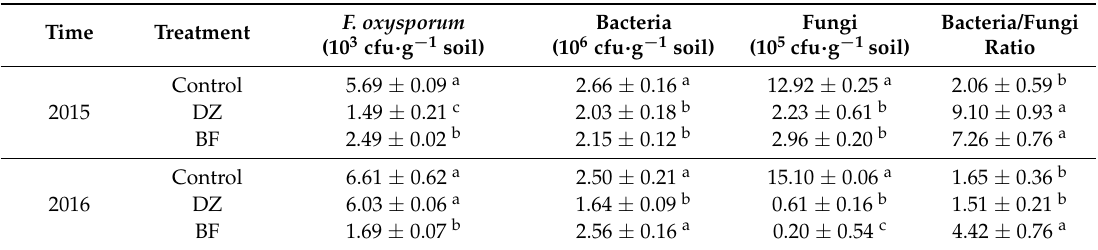
Bacteria Fungi Bacteria/Fungi (10 6 cfu · g − 1 soil) (10 5 cfu · g − 1 soil) Ratio